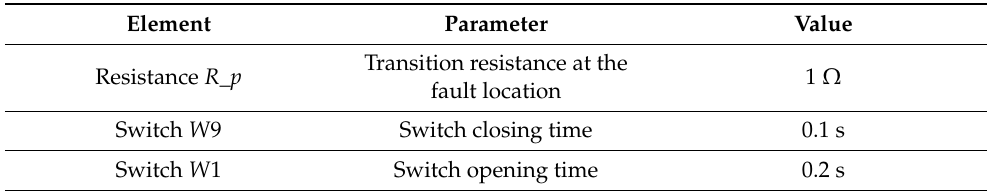
Table 2. Parameters of elements and operations of the power grid model contributing to the excitation of nonlinear